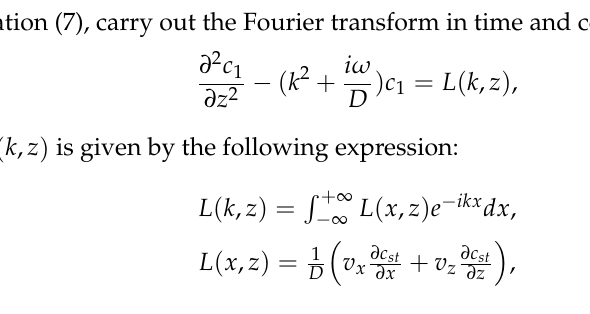
Figure 1. Single planar electrode.